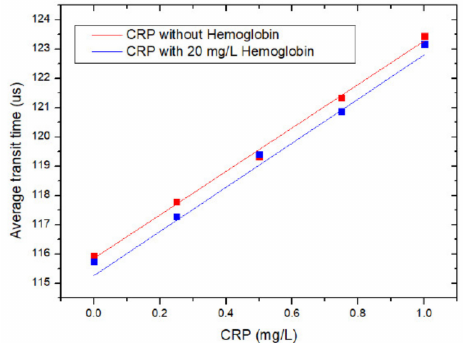
Figure 7. The interference of hemoglobin to CRP